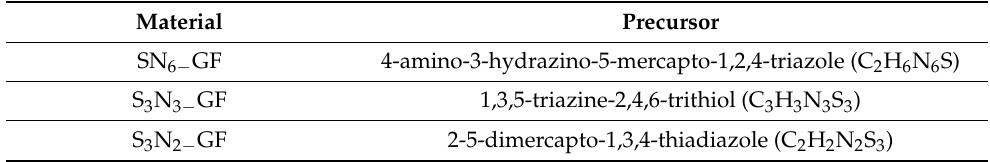
Table 1. Description of the different precursor materials used in this